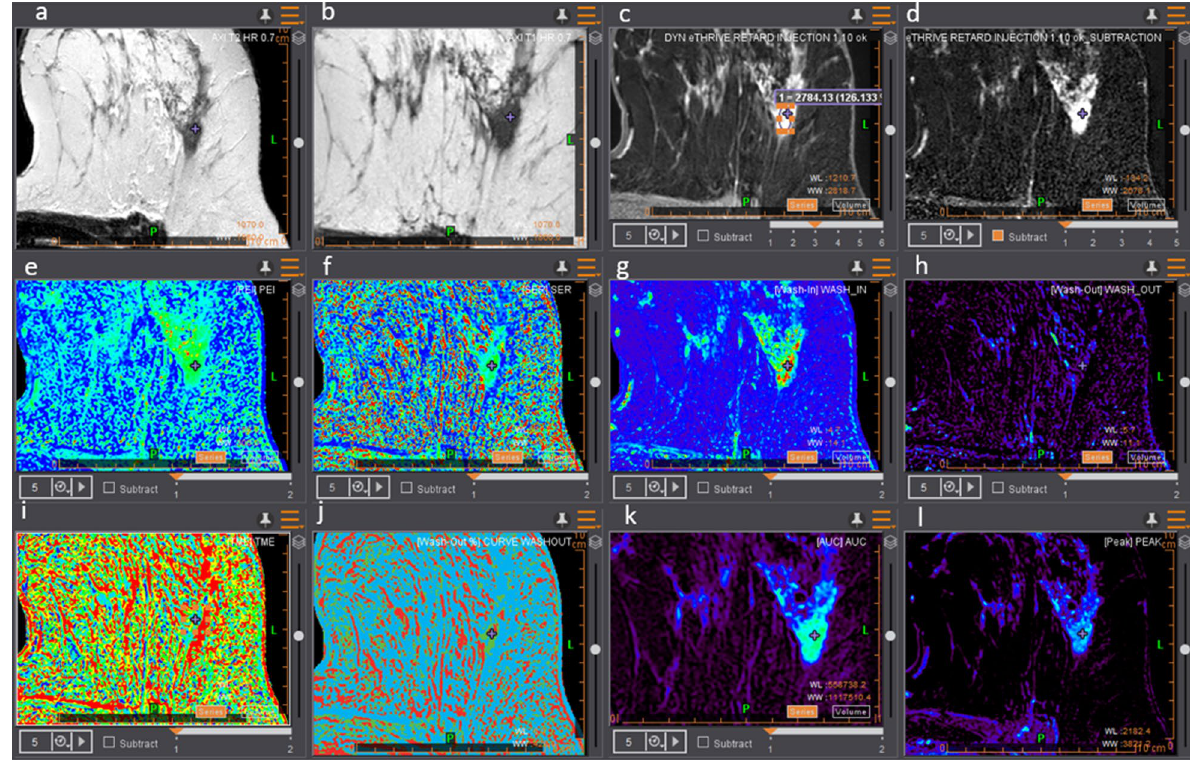
Fig. 4 Example of a grade II infiltrating carcinoma of the left breast at the meeting point of the lateral quadrants: a T2-weighted sequence in axial view, b T1-weighted sequence in axial view, c Dynamic contrast enhancement 3 native, d Dynamic contrast enhancement 1 subtracted, e PEI map,